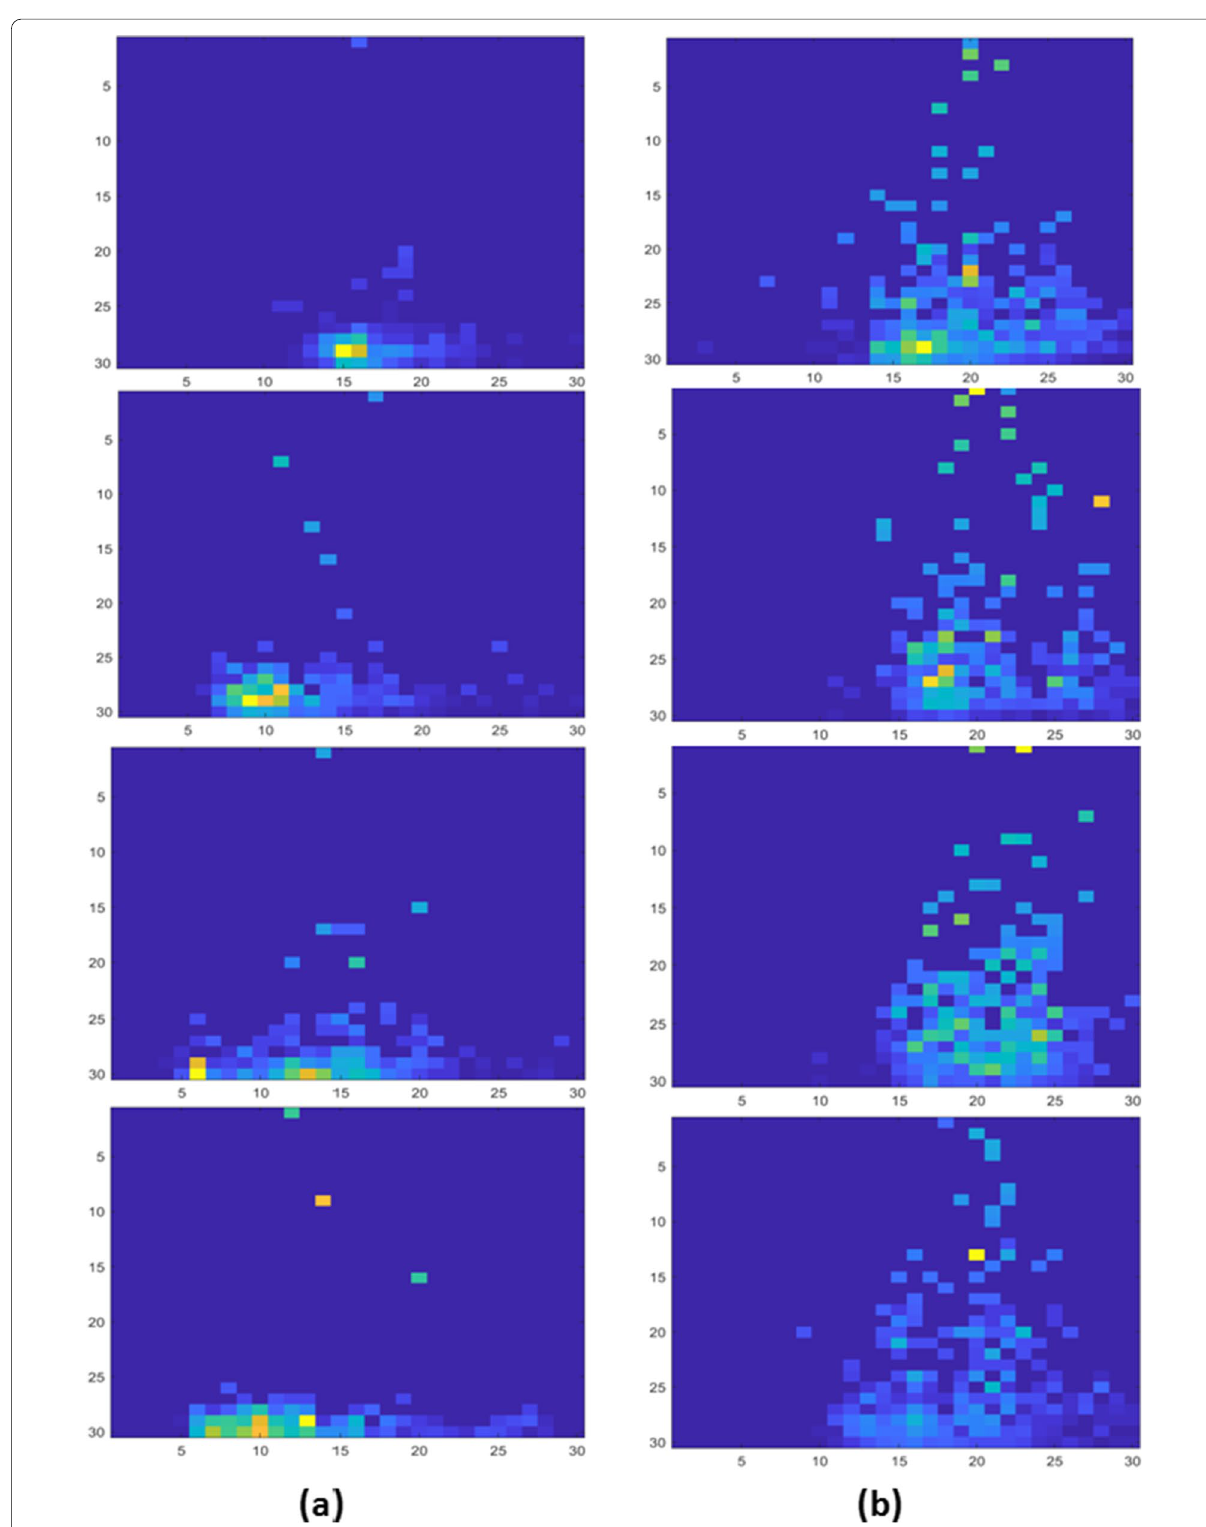
Fig. 3 A persistence image representation of hepatic decompensation within a year. Persistence image is showing topologic data analysis stable vectorization for both ( a ) patients developing hepatic decompensation within a year and ( b ) patients not developing hepatic decompensation within a